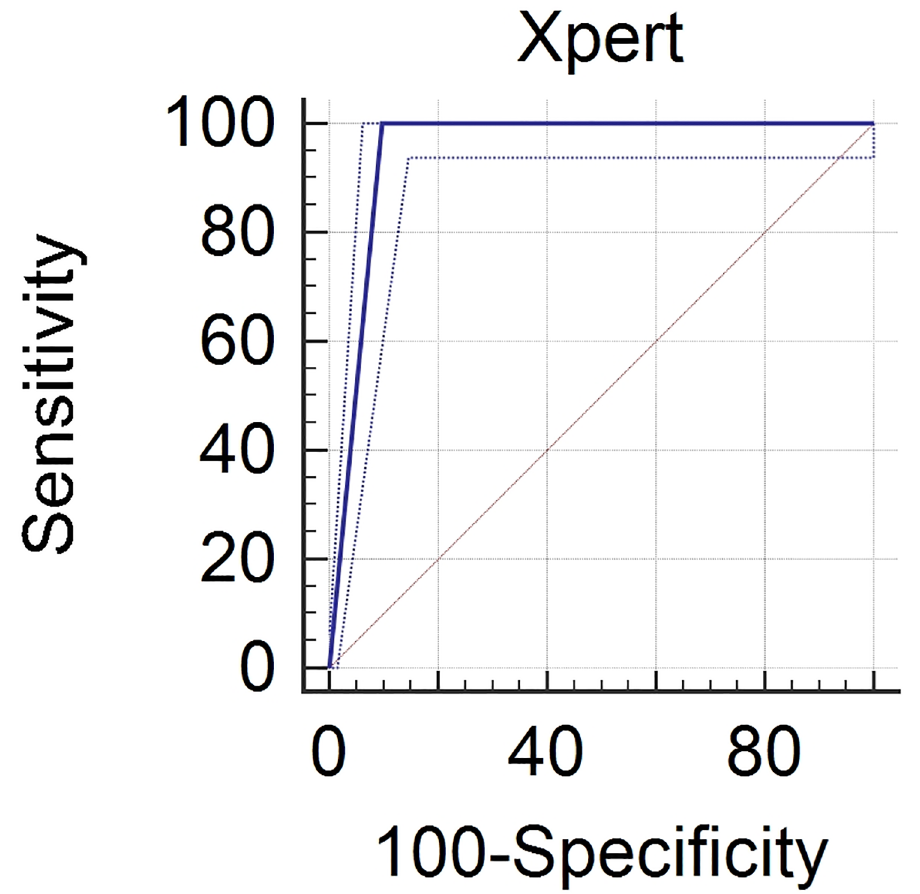
Fig 1. Receiver operating characteristic (ROC) curve for the detection of tuberculosis with Xpert MTB/RIF test. (The area under the ROC curve was 0.95 for the Xpert MTB/RIF test [95% CI 0.93 to 0.97; p < 0.0001]).